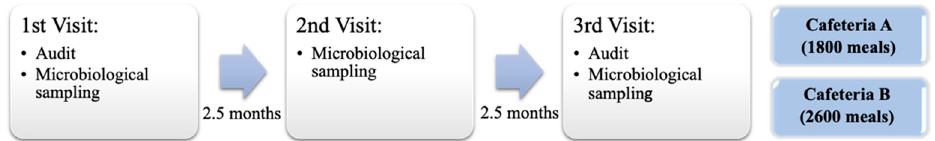
Figure 1. Visits scheme to FSOp-A and FSOp-B.